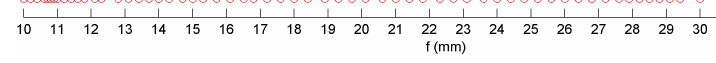
Figure 6. The sequential EXIF focal lengths for the Nikon 1 J4.